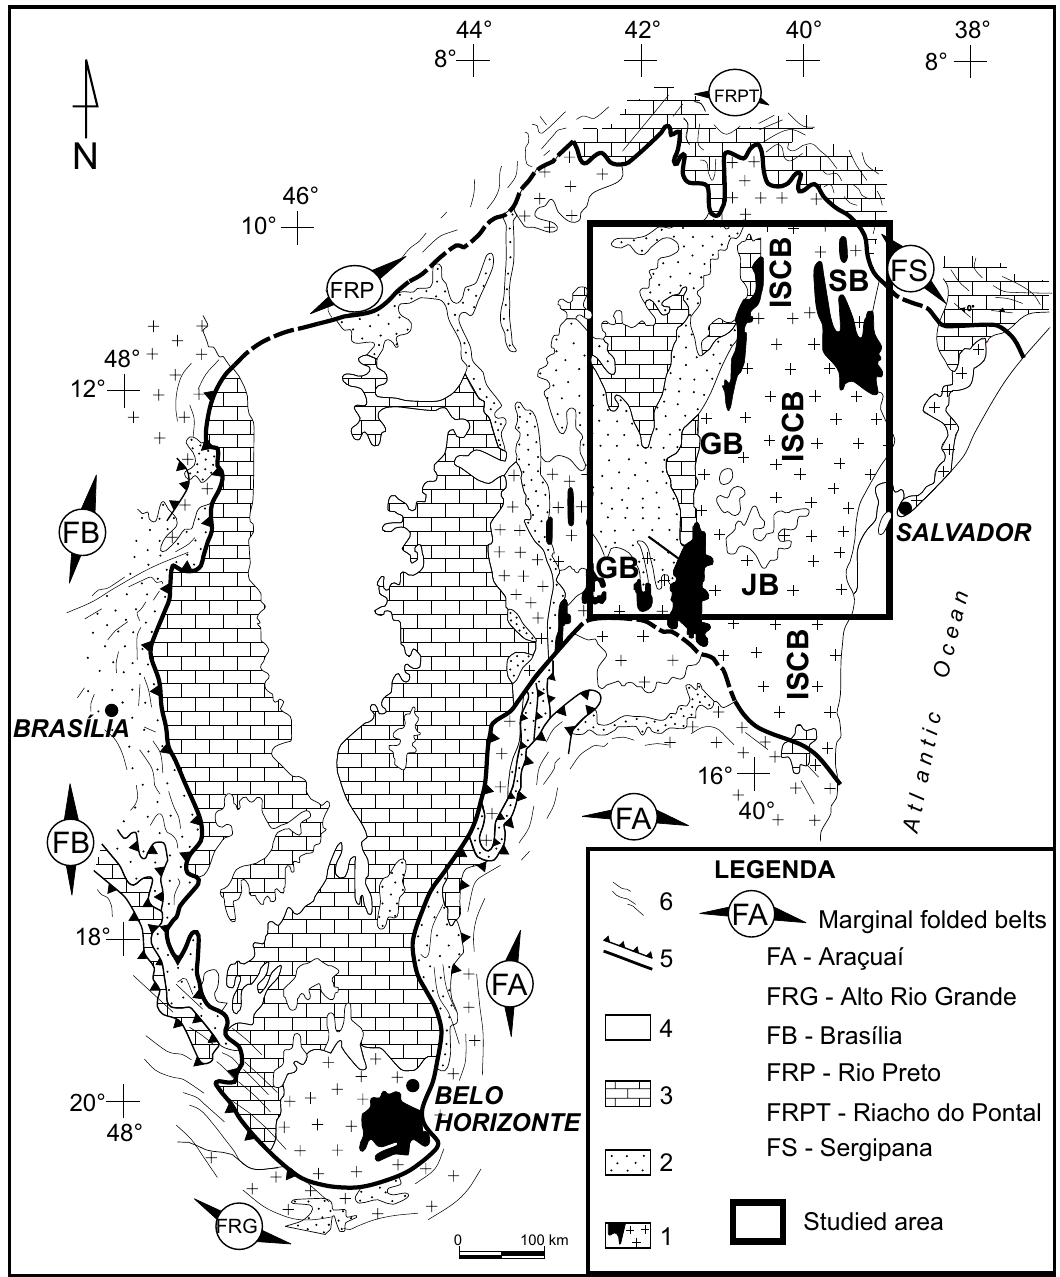
Fig. 1 – Sketch map showing the boundaries and the major structural units of the São Francisco Craton. 1. Archean/Paleoproterozoic basement with greenstone belts sequences (black); 2. Mesoproterozoic units 3. Neoproterozoic units; 4. Phanerozoic covers; 5. Craton limits; 6. Brasilian fold belts; GB. Gavião Block. JB. Jequié Block. SB. Serrinha Block; ISCB. Itabuna-Salvador-Curaçá Belt. This figure shows the studied area. Adapted from Alkmim et al. (1993).